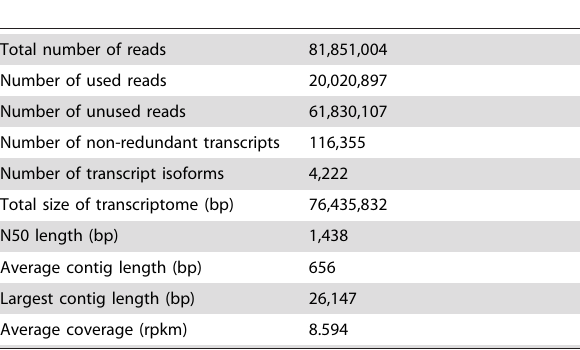
Table 1. The Lymnaea TSA obtained from Rnnotator